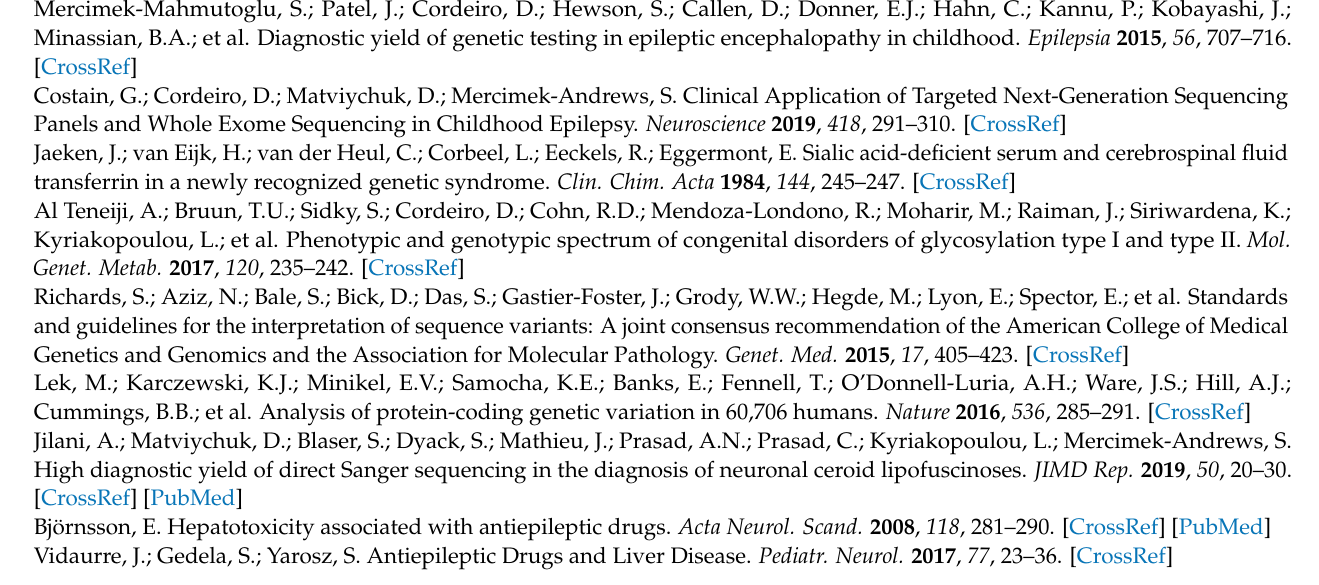
Table S2: Please refer to our previously published studies for the results of the 48 patients with genetic diagnoses, who were included into the current study. Table S3: In silico analysis of variants in